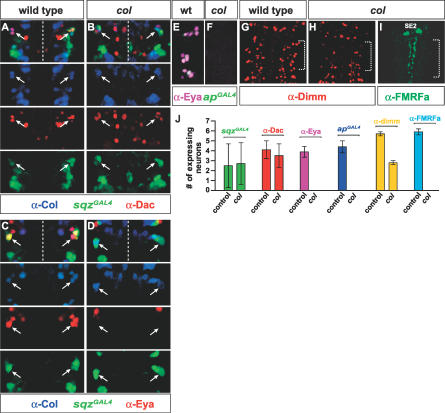

col Regulates ap, eya, dimm, and FMRFa, but Not sqz and dac
(A–I) Expression of Ap neuron determinants and of FMRFa (I), in wild-type and col mutants at stage 15 (A–D) and 18 h AEL (E–I). Dashed lines in (A–D) depict the VNC midline.(A and C) In wild type, expression of Col (blue), sqzGAL4 (green), Dac (red), and Eya (red) clearly visualizes the early Ap cluster (arrows).(B and D) In col mutants, although sqzGAL4and Dac expression is largely unaffected (B), there is a complete loss of Eya expression in the Ap cluster (D, arrows).(E and F) In the late embryonic VNC, Eya and apGAL4 are readily detected in all three thoracic hemisegments in the wild type (E), whereas col mutants show complete loss of expression of both markers (F).(G and H) Similarly, Dimm expression (red) is lost from lateral thoracic peptidergic neurons in col mutants (bracket). Staining for other neuropeptides such as CCAP and Corazonin reveals that Dimm expression is specifically lost from Tv, Tvb, and dAp peptidergic neurons (unpublished data).(I) As expected from the loss of several Ap neuron determinants, FMRFa expression (green) is completely lost from Tv neurons (bracket). As with other mutations specifically affecting Tv neurons, expression of FMRFa is not lost from the SE2 neurons (SE2).(J) Quantification of the observed phenotypes (for sqzGAL4, Dac, Eya, and apGAL4, n > 65 clusters; for Dimm, n > 65 thoracic hemisegments; and for FMRFa, n > 24 VNCs). sqzGAL4, Dac, and Eya are quantified at stage 15, whereas apGAL4, Dimm, and FMRFa are quantified at 18 h AEL.Genotypes: (A and C) UAS-nmEGFP/+; sqzGAL4/+, (B and D) col1, UAS-nmEGFP/col 3 sqzGAL4/+, (E) apGAL4/+; UAS-nmEGFP/+, (F) col1, apGAL4/col3; UAS-nmEGFP/+, (G) w1118, and (H and I) col1/col3. (J) Controls are: UAS-nmEGFP/+; sqzGAL4/+ for sqz, Dac, and Eya expression; apGAL4/+; UAS-nmEGFP/+ for ap expression; and w1118 for Dimm and FMRFa expression.